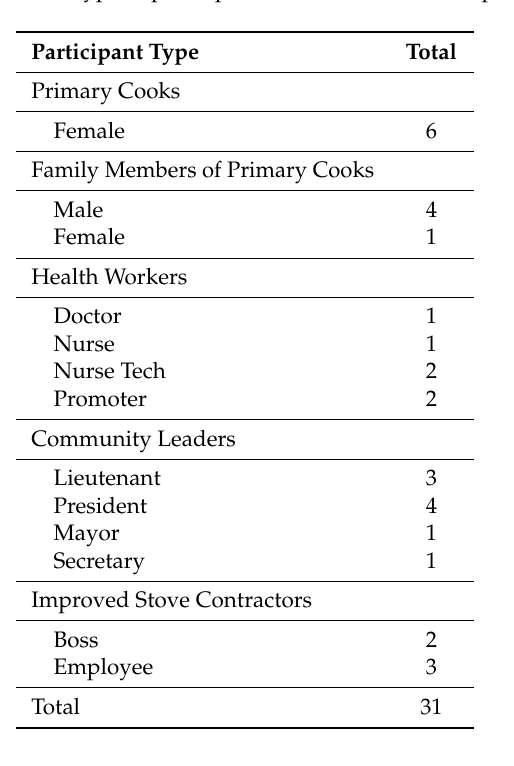
Table 1. Number and type of participants included in the in-depth